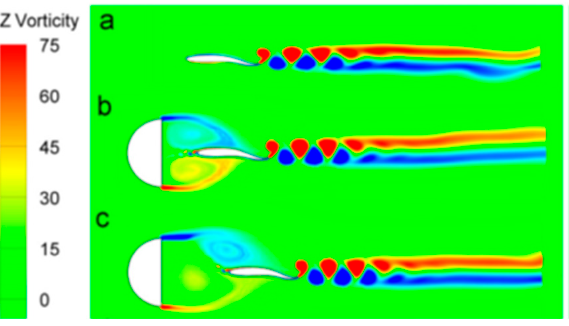
Figure 4. Multibody disturbance of cylinder and wing [16].